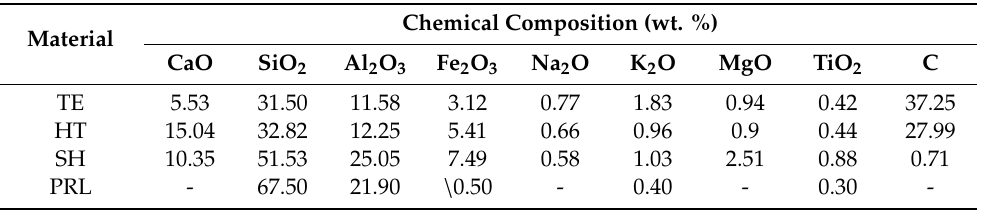
Table 2. Main chemical composition of raw